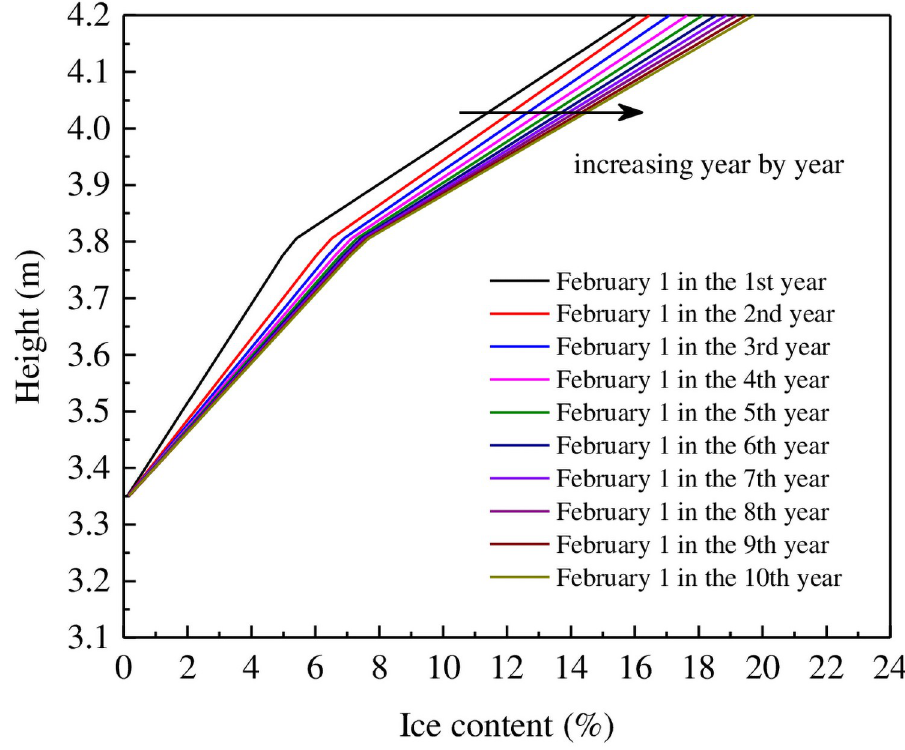
Fig 14. Modeled variations of ice content (%) under the centerline of the railway embankment section on February 1 each year after construction.